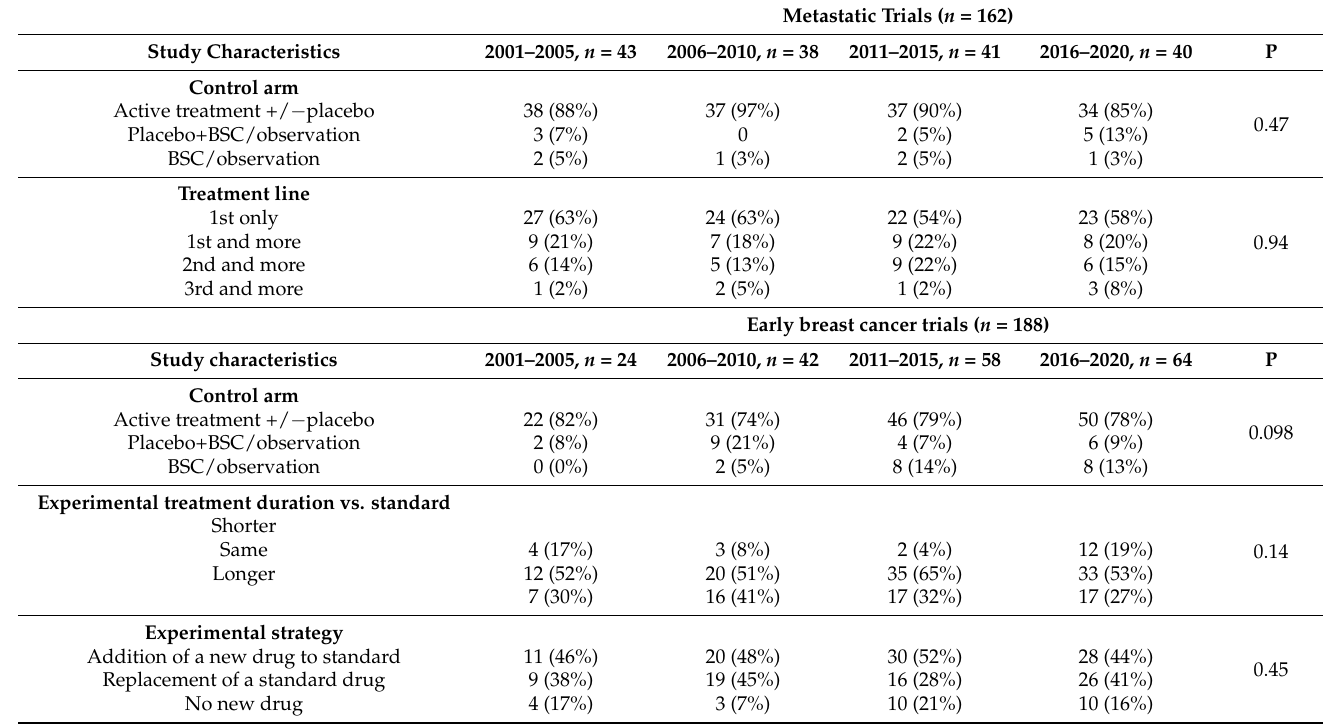
Table 3. Trial strategy over time according to clinical